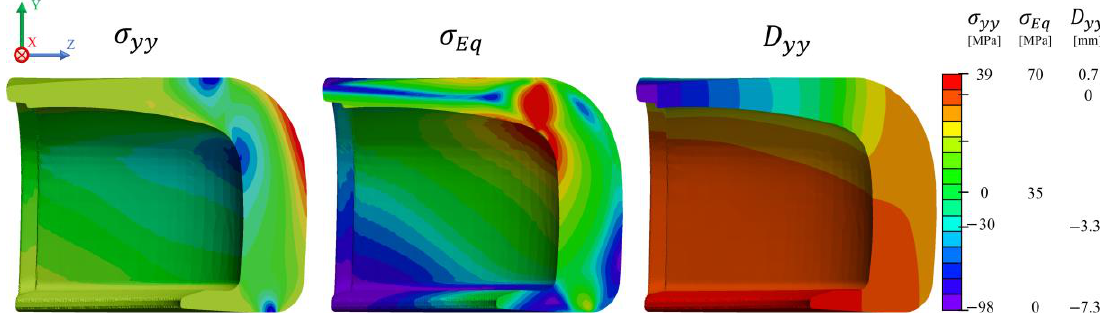
Figure 14. Normal stress ( σ yy ), von Mises Stress ( σ Eq ) and cell y-displacement ( D yy ) distribution inside the toe cap for compressive simulation, when Fy plate = 15 kN.